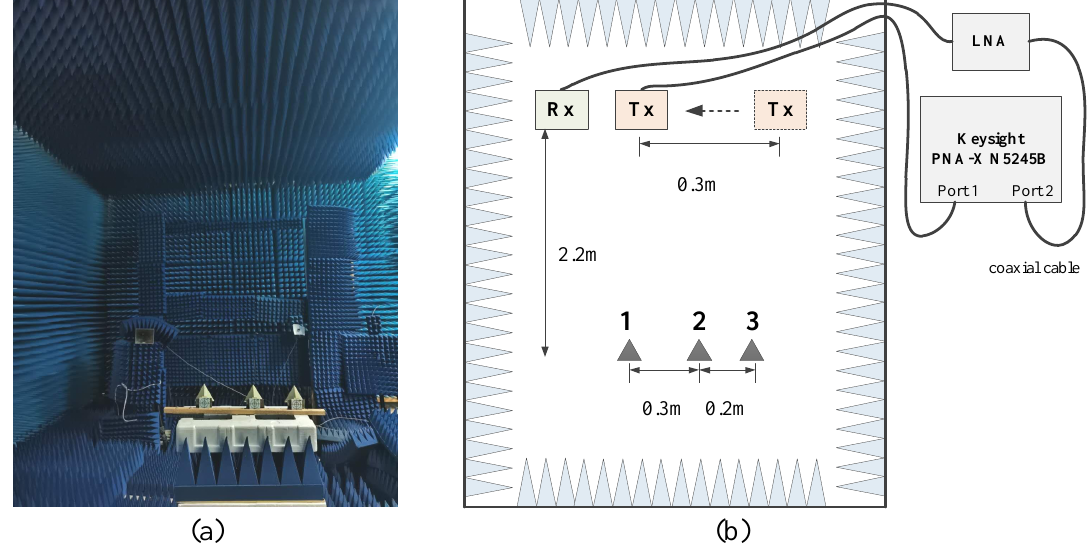
Figure 10. Scenario of imaging experiment in microwave anechoic chamber. ( a ) is the real-world scenario. ( b ) is the geometrical scenario